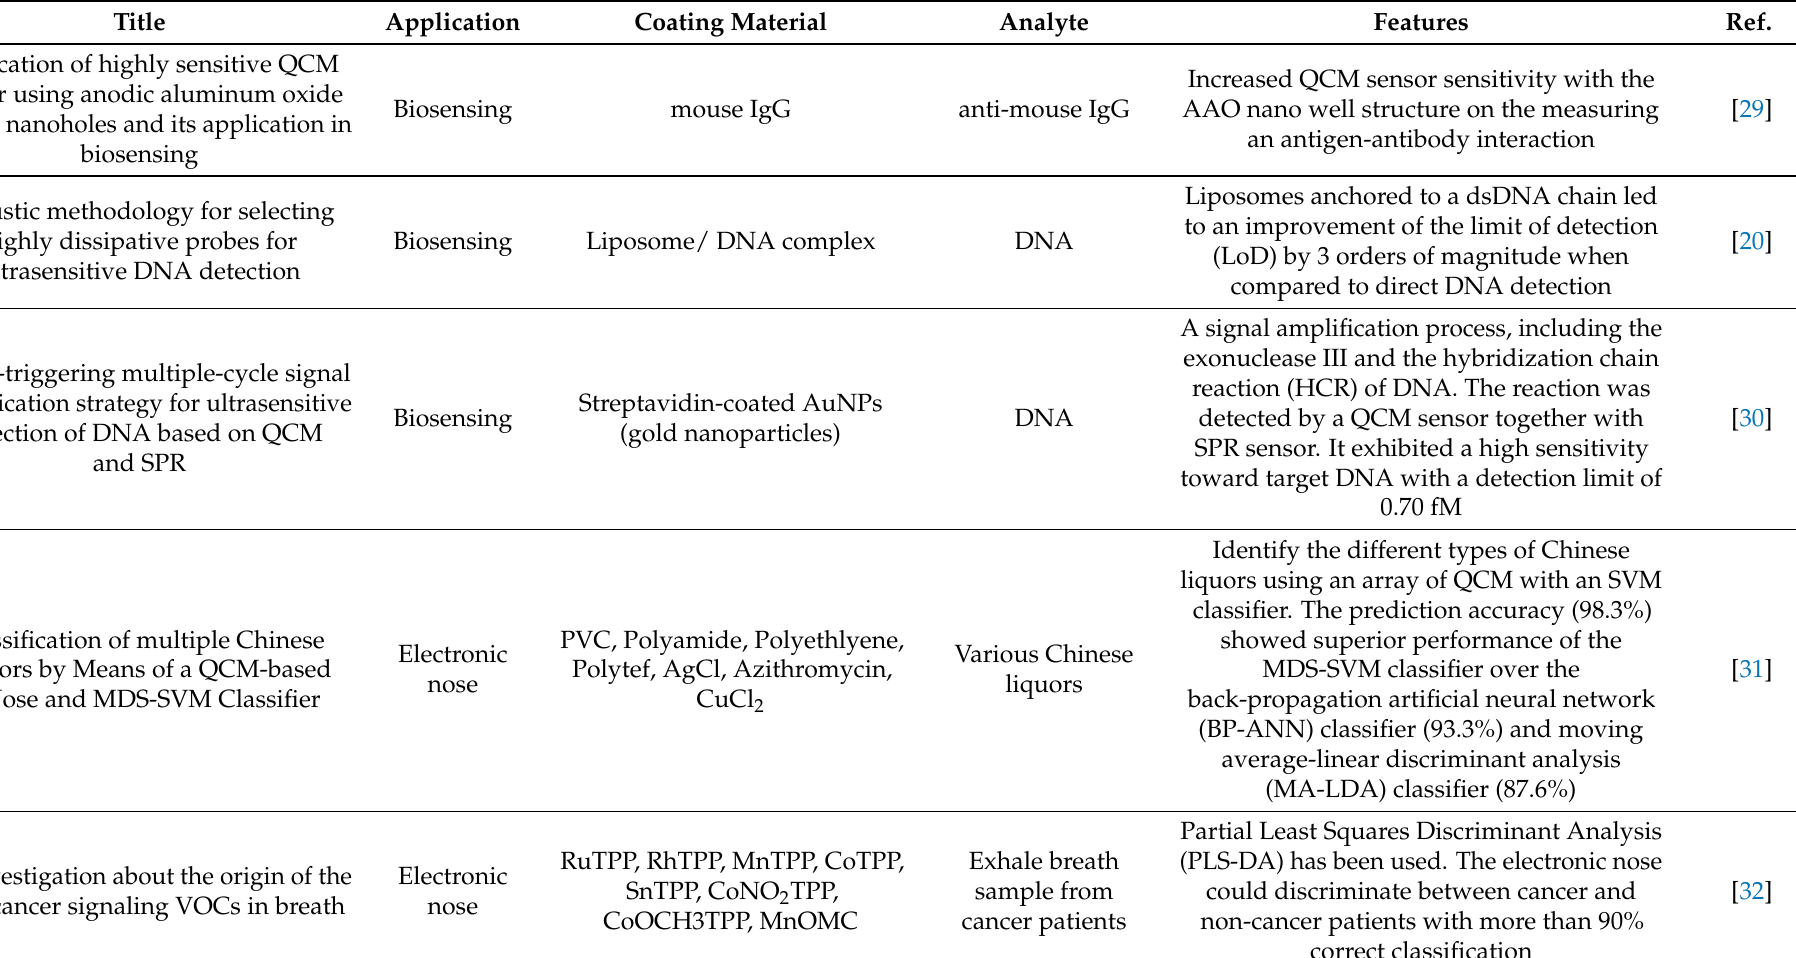
Table 1. Selection of the recent QCM